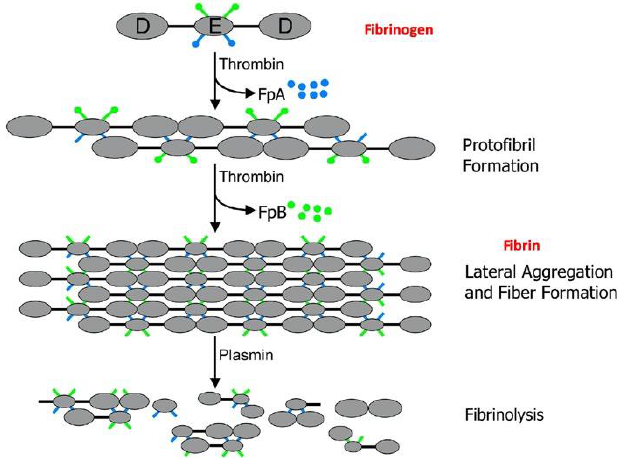
Figure 2. Fibrinogen is converted into fibrin via a two-step enzymatic reaction by thrombin. The cleavage of fibrinopeptide A (FpA) allows for protofibril formation. The cleavage of fibrinopeptide B (FpB) allows for later aggregation leading to fibrin fibril formation. In vivo, the plasmin protease is able to degrade the fibrin fibers. Adapted and reproduced with permission from [69]. Copyright 2006 Elsevier Ltd.